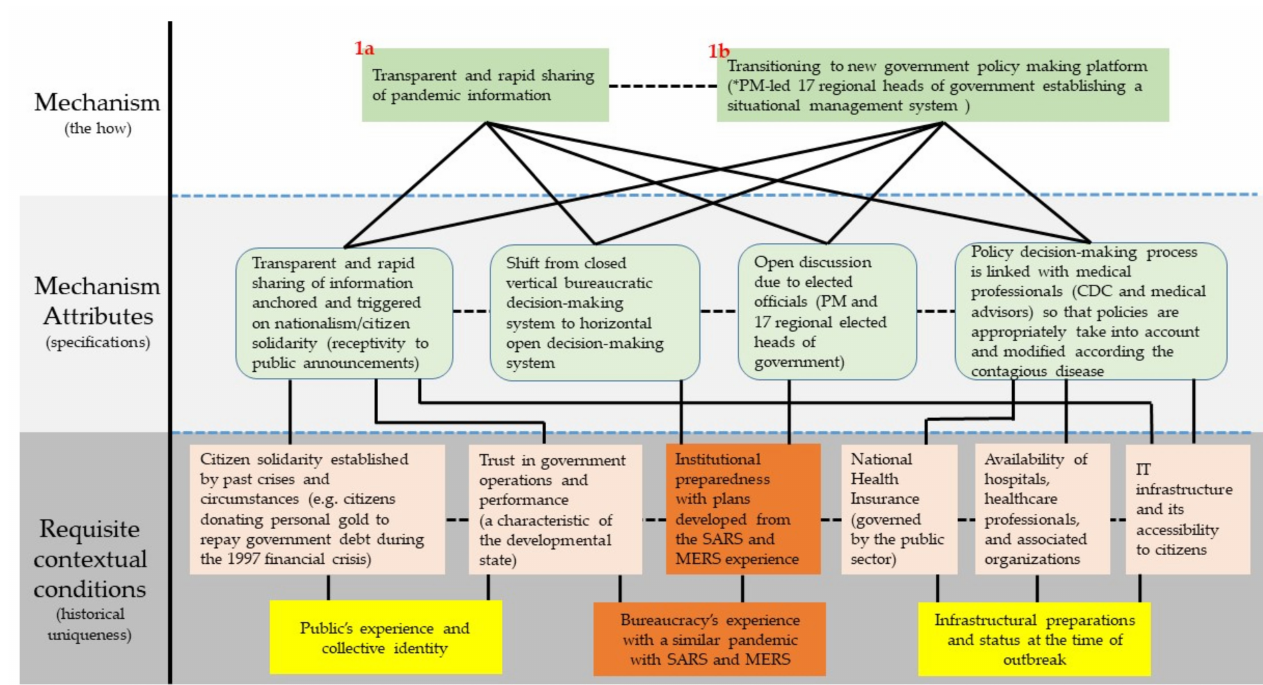
Figure 4. Diagram elaborating requisite contextual